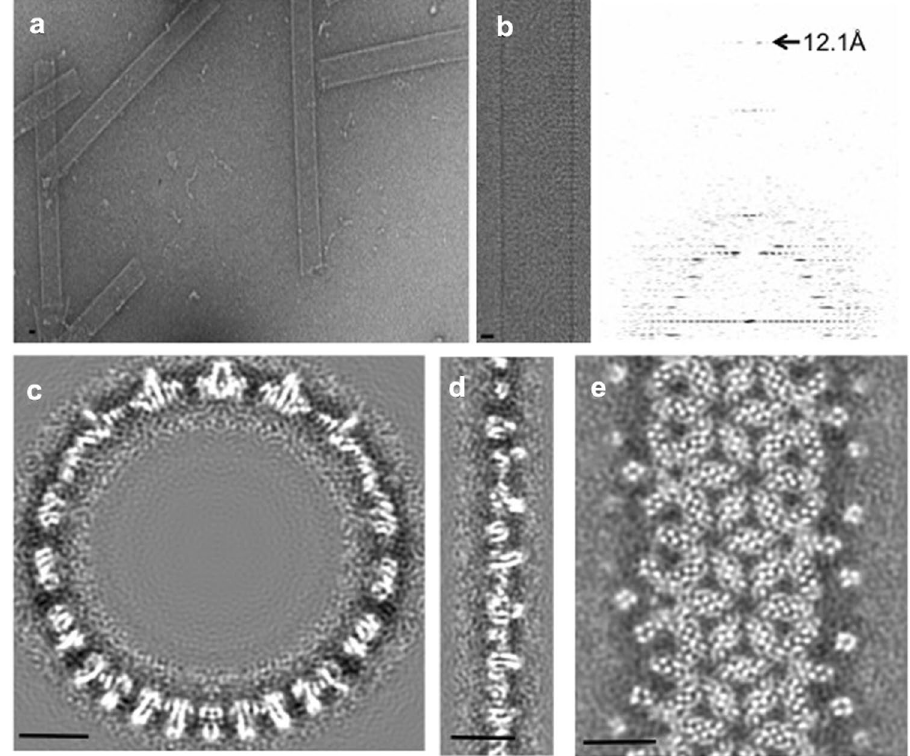
Figure 1. Electron microscopy and 3-D reconstruction of HBc tubular ensembles. ( a ) Electron micrograph of negatively-stained HBc tubular ensembles. ( b ) A representative cryo-EM image of the HBc tubular ensembles and its Fourier transform. The visible diffraction layer lines extend to 12.1 Å. The reconstructed HBc tubular ensemble viewed from its top ( c ), edge ( d ), and side ( e ). In all images, scale bars represent 100